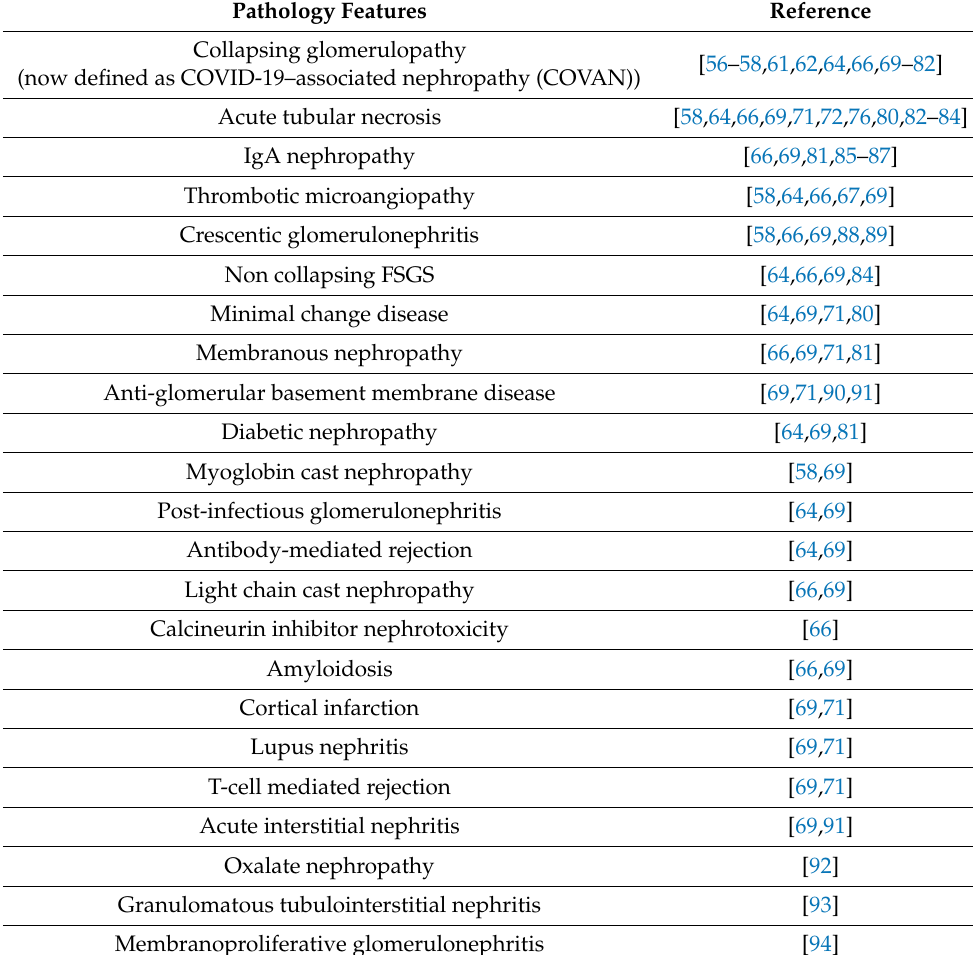
Table 1. Pathology features of kidney involvement in